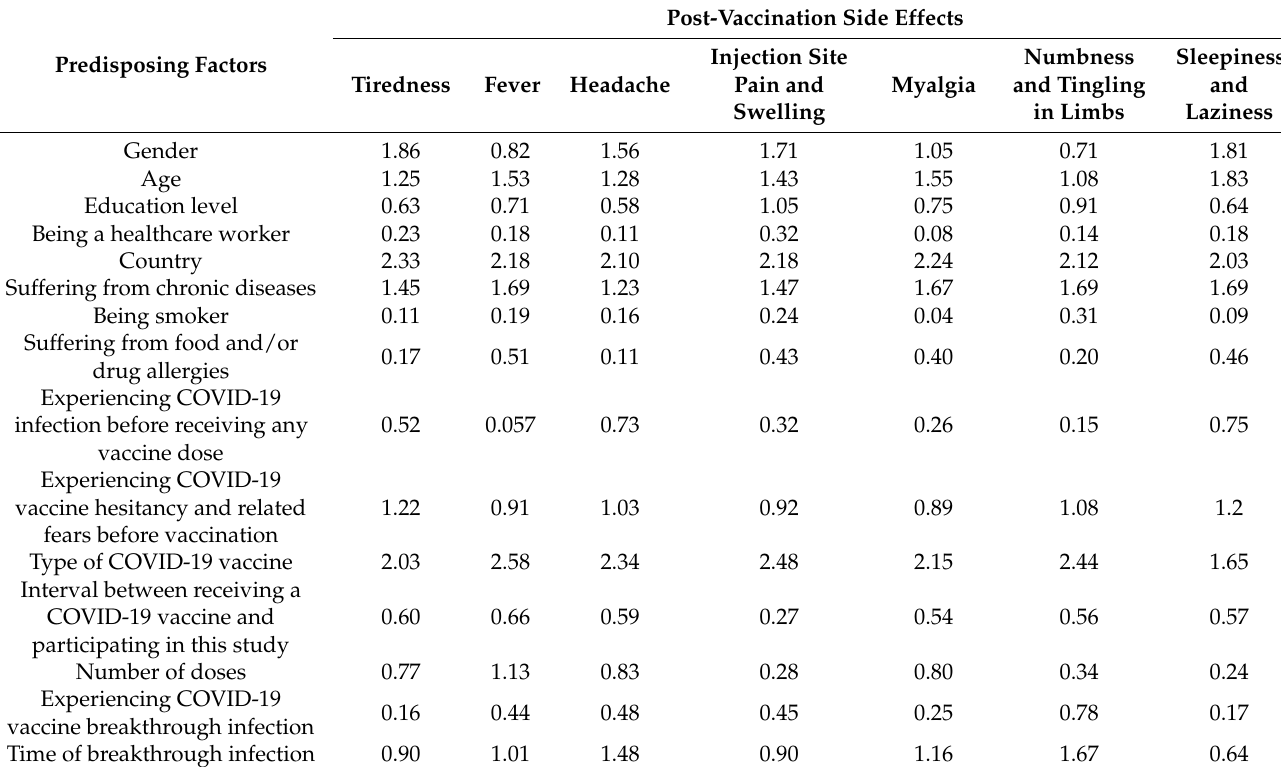
Table 7. Feature importance values resulted from gradient boosting.